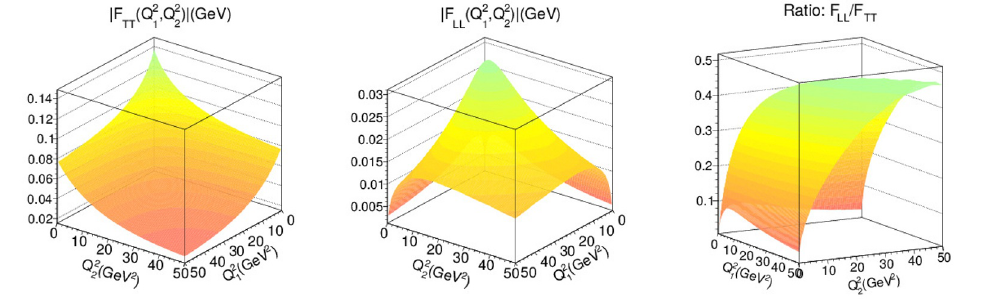
Figure 3 . j F TT j (left) and F LL (middle) form factors and their ratio (right) for the Buchm(cid:127)uller-Tye potential for the (cid:31) c 0 wave function.